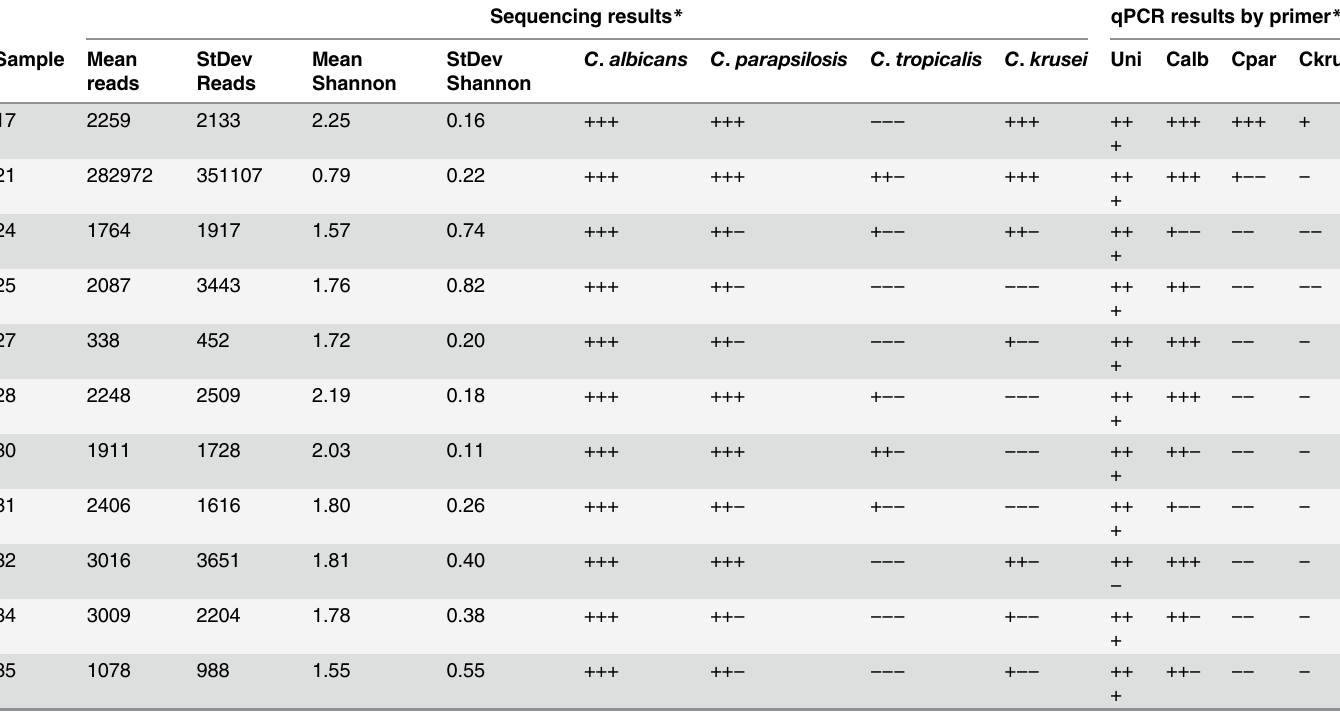
Table 4. Comparison of data from sequencing and qPCR for eleven infant fecal